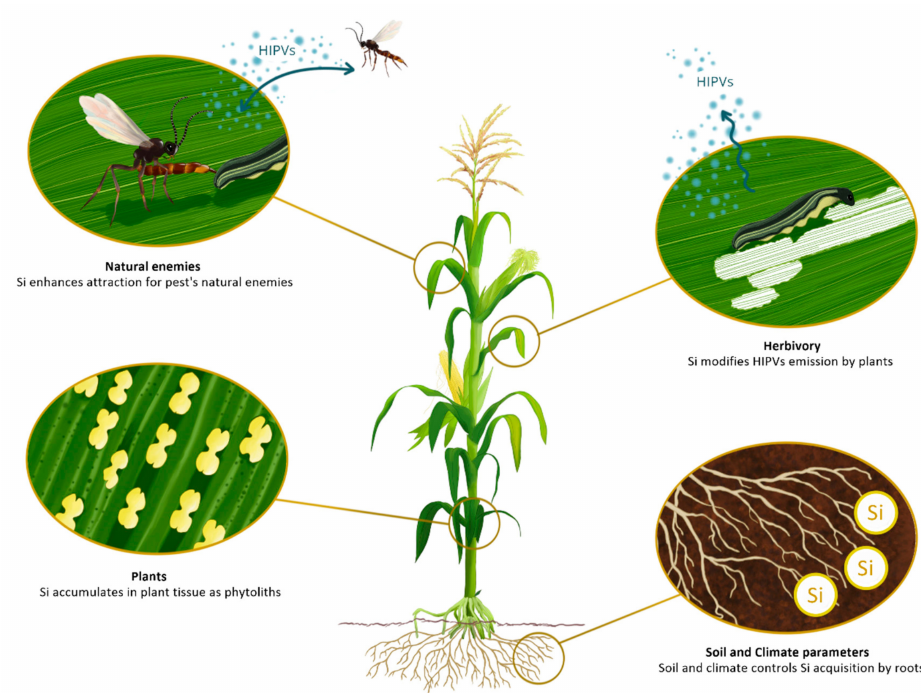
Figure 1. Soil and climatic parameters control silicon (Si) assimilation by terrestrial plants. Si is available in the soil solution as uncharged monomeric monosilicic acid (H 4 SiO 4 ) and plants accumulate Si as amorphous hydrated silica (SiO 2 · nH 2 O, called phytoliths) in the epidermal cells. Herbivore-Induced Plant Volatiles (HIPVs) emissions by plants are modified by Si, that in turn a ff ect tritrophic interactions. Drawing by Levicek Carolina & Nguyen